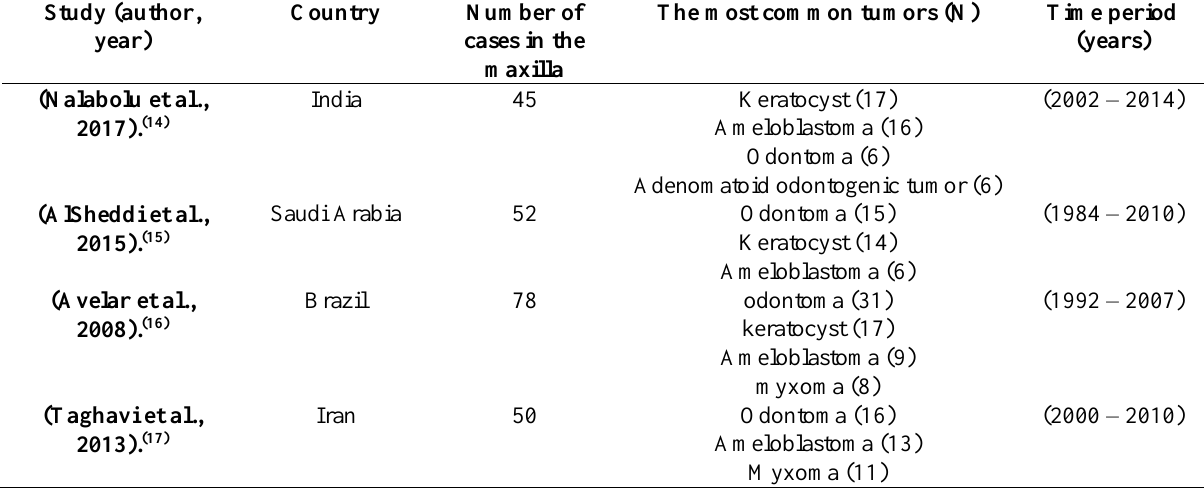
Table 4: The characteristics of maxillary odontogenic tumors in comparison studies Study